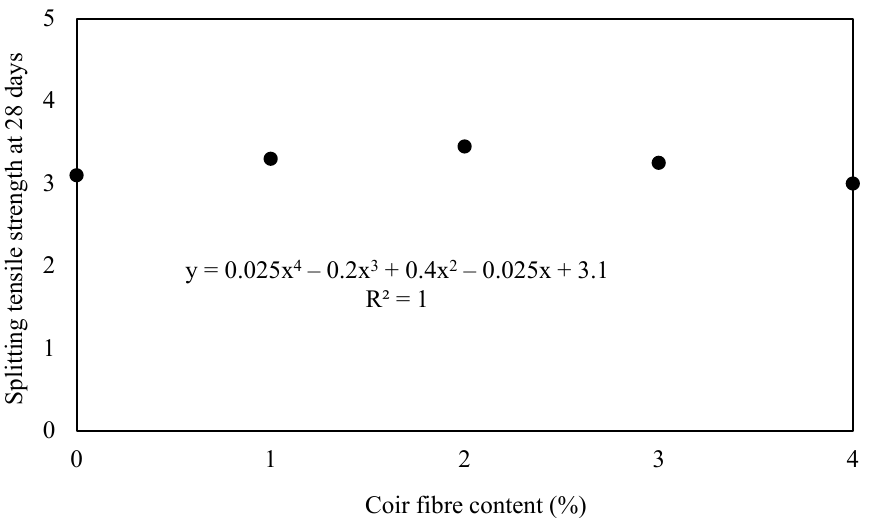
Figure 7. A fourth-degree relationship between the content of coir fiber and the splitting tensile strength of the coir fiber-modified concrete.